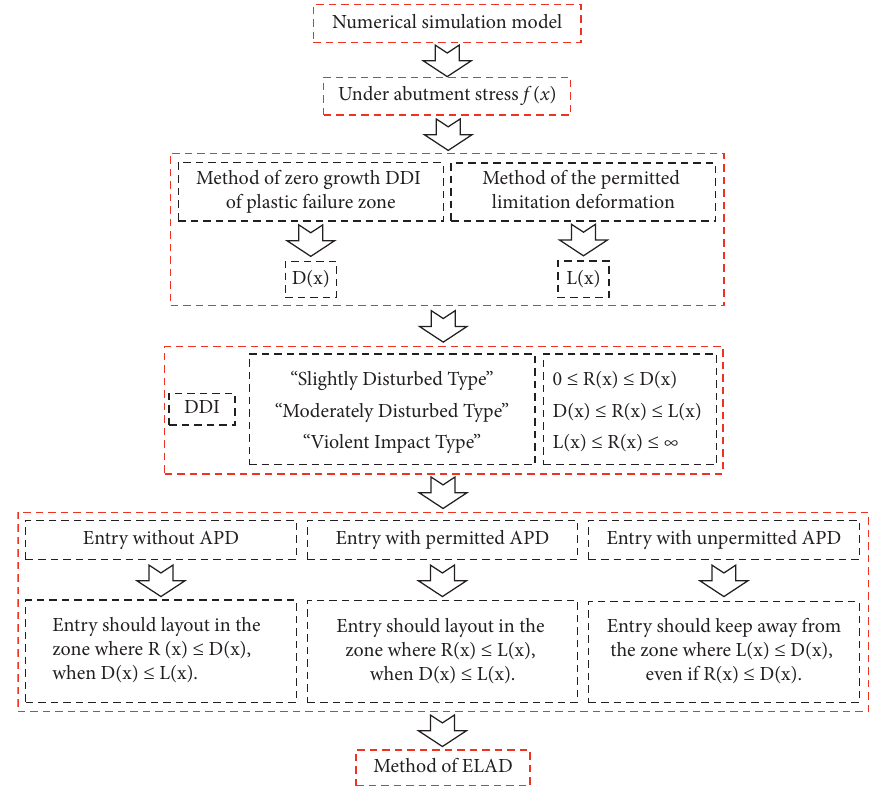
Figure 2: Detailed solution of the entry layout